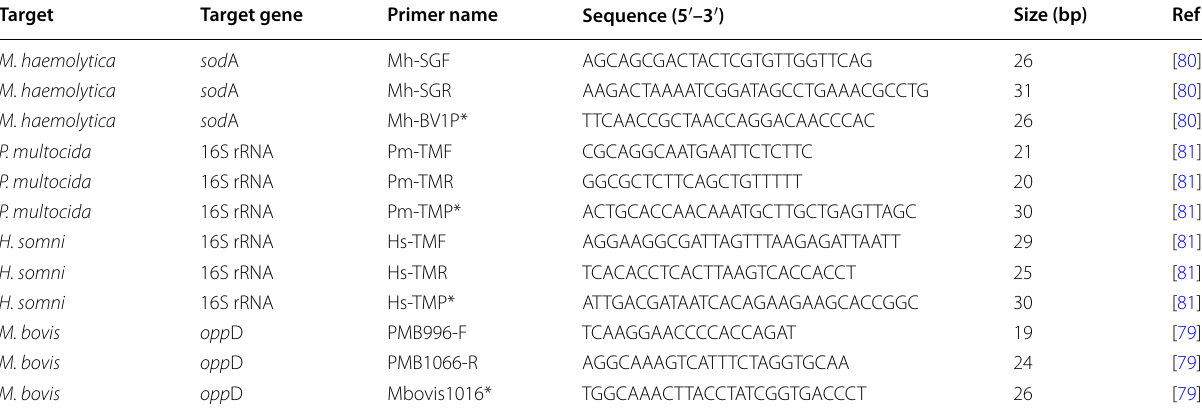
Table 2 BRD pathobiont primers and probes sequences for PCR and qPCR